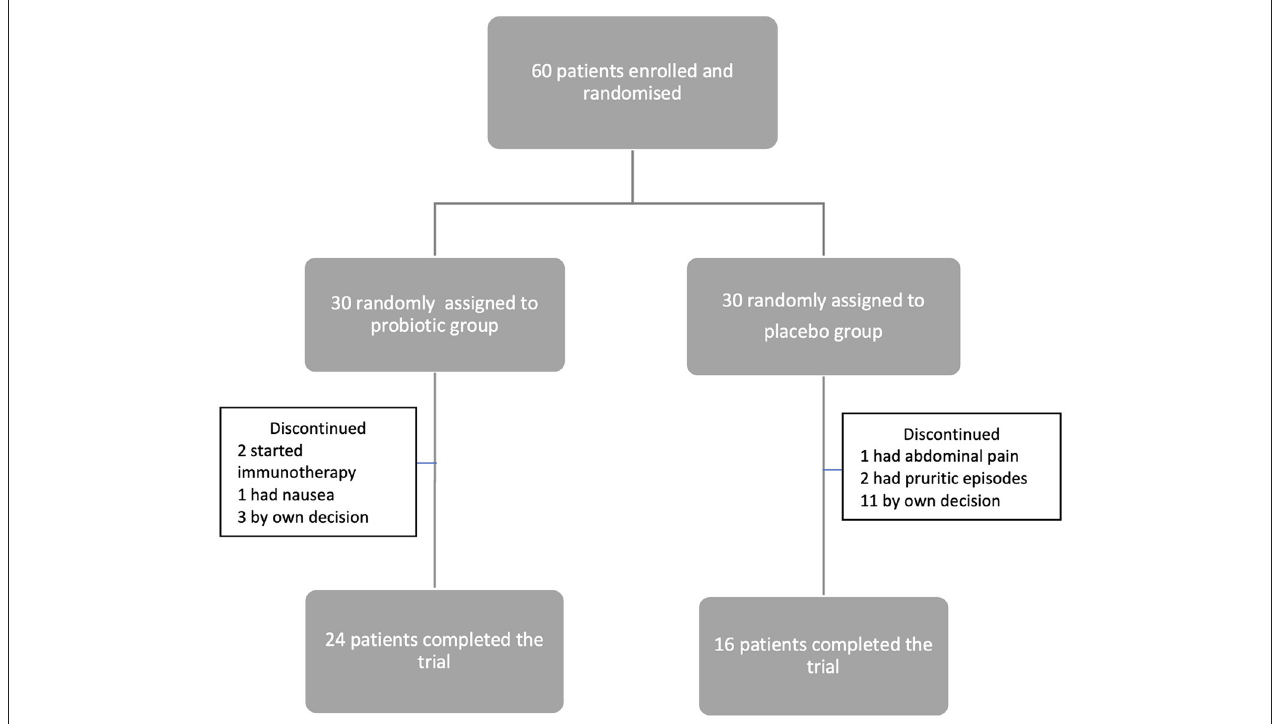
FIGURE 1 | Flowchart of patient inclusion, allocation, and